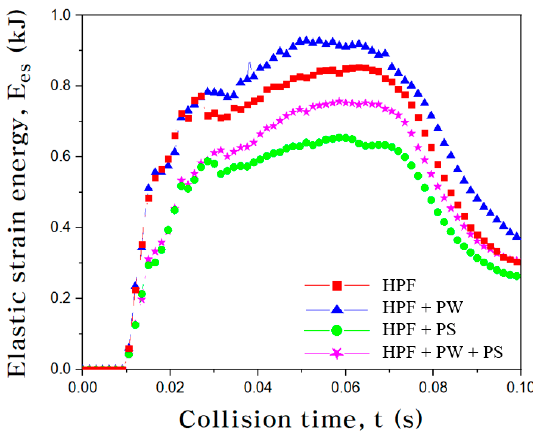
Figure 12. Elastic strain energy ( E es ) of the four kinds of the center pillar during a side crash.